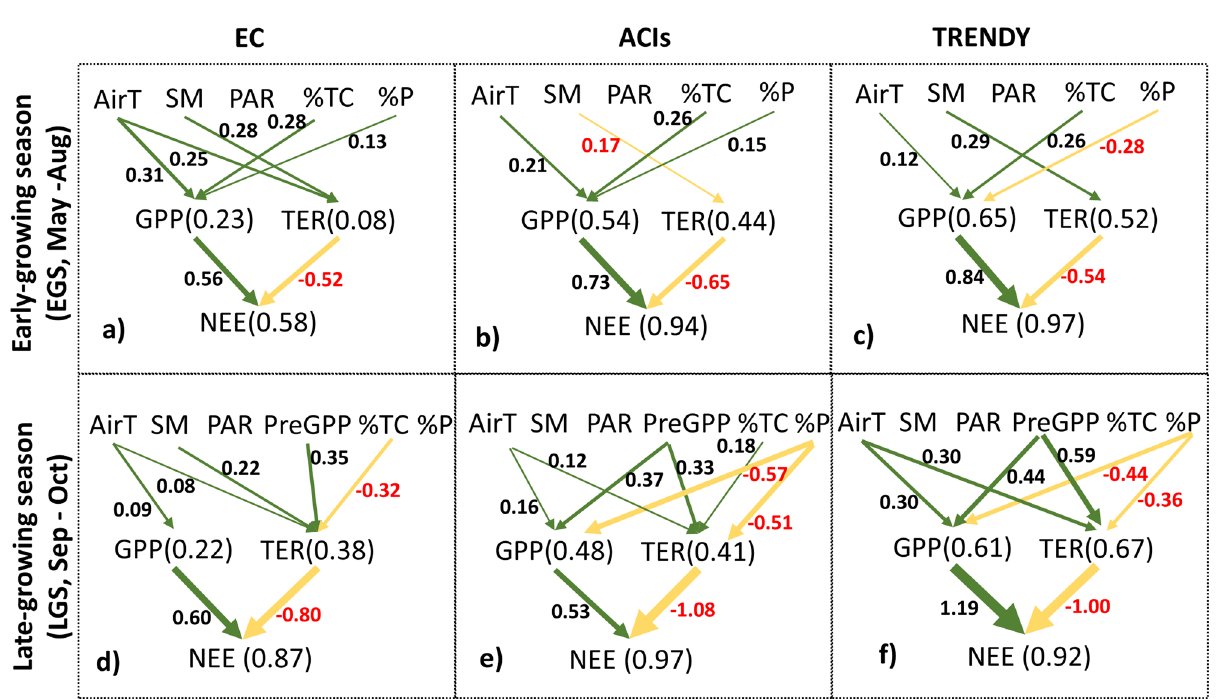
Fig. 5 | Climate and environmental controls on net CO 2 uptake vary among seasons, and DGVMs need to better capture the respiration processes during the late-growing season. Structural equation models (SEMs) of the relative in fl u- ence of component fl uxes (i.e., gross primary productivity (GPP) and total eco- system respiration (TER)) on net CO 2 uptake (i.e., net ecosystem exchange: NEE) and climatic and environmental controls including air temperature (AirT), soil moisture(SM),photosyntheticallyactive radiation(PAR), preseason GPP(PreGPP), percent tree cover (%TC), and percent of permafrost extent (%P) on CO 2 fl uxes in the NHL. Only signi fi cant paths are shown ( p <0.05) with the standardized